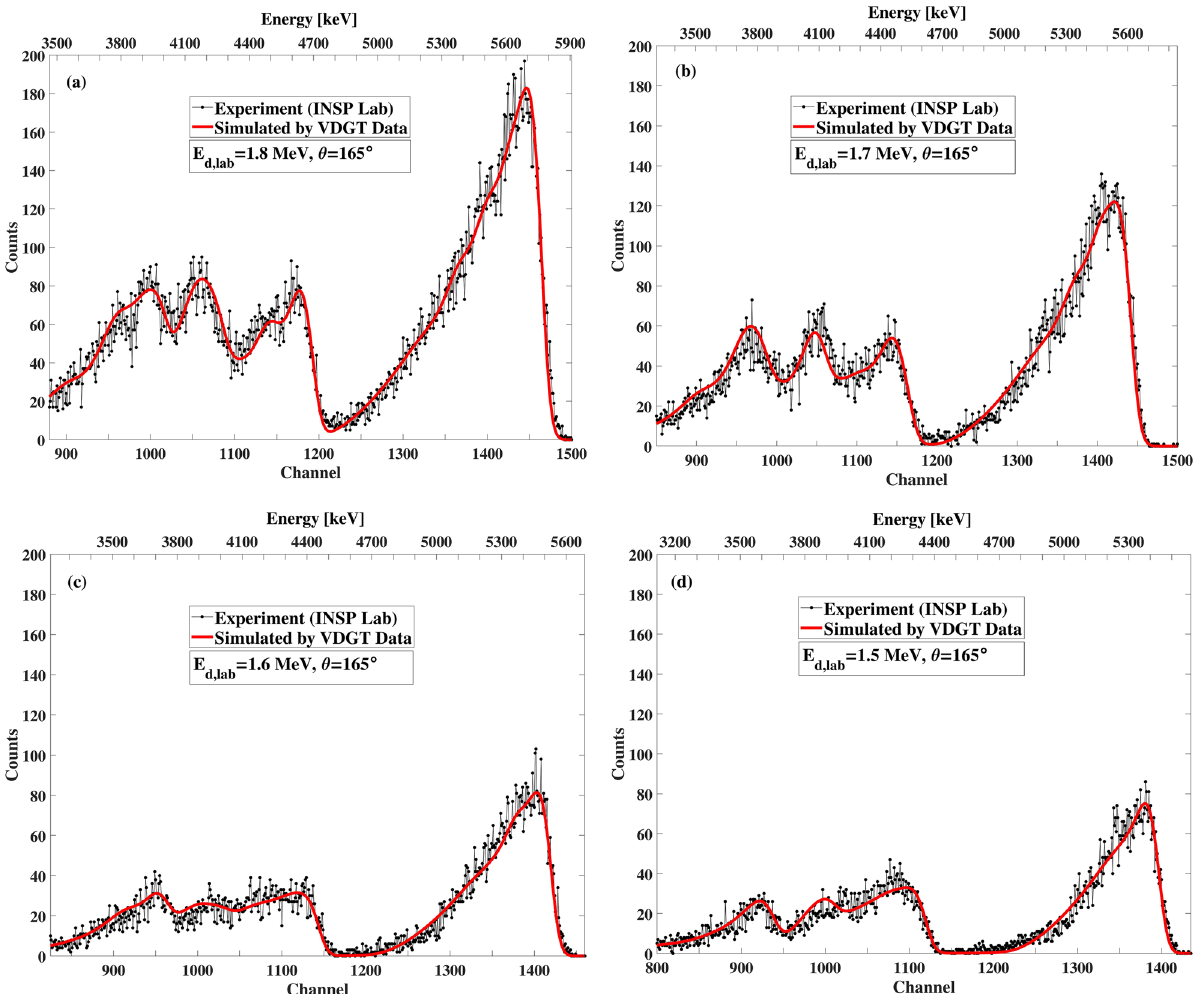
Figure 19. The benchmarking result at INSP Lab in Paris with measured VDGT data at 165° for different incident deuteron energies of ( a ) 1.8 MeV, ( b ) 1.7 MeV, ( c ) 1.6 MeV, ( d ) 1.5